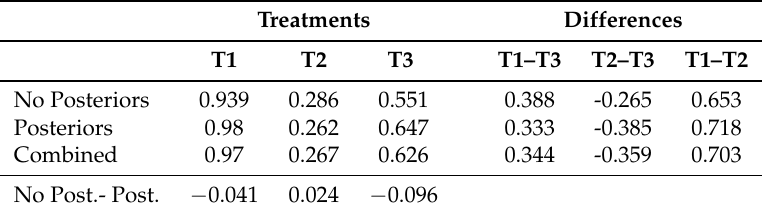
Table 8. Informative/naive voting of type a